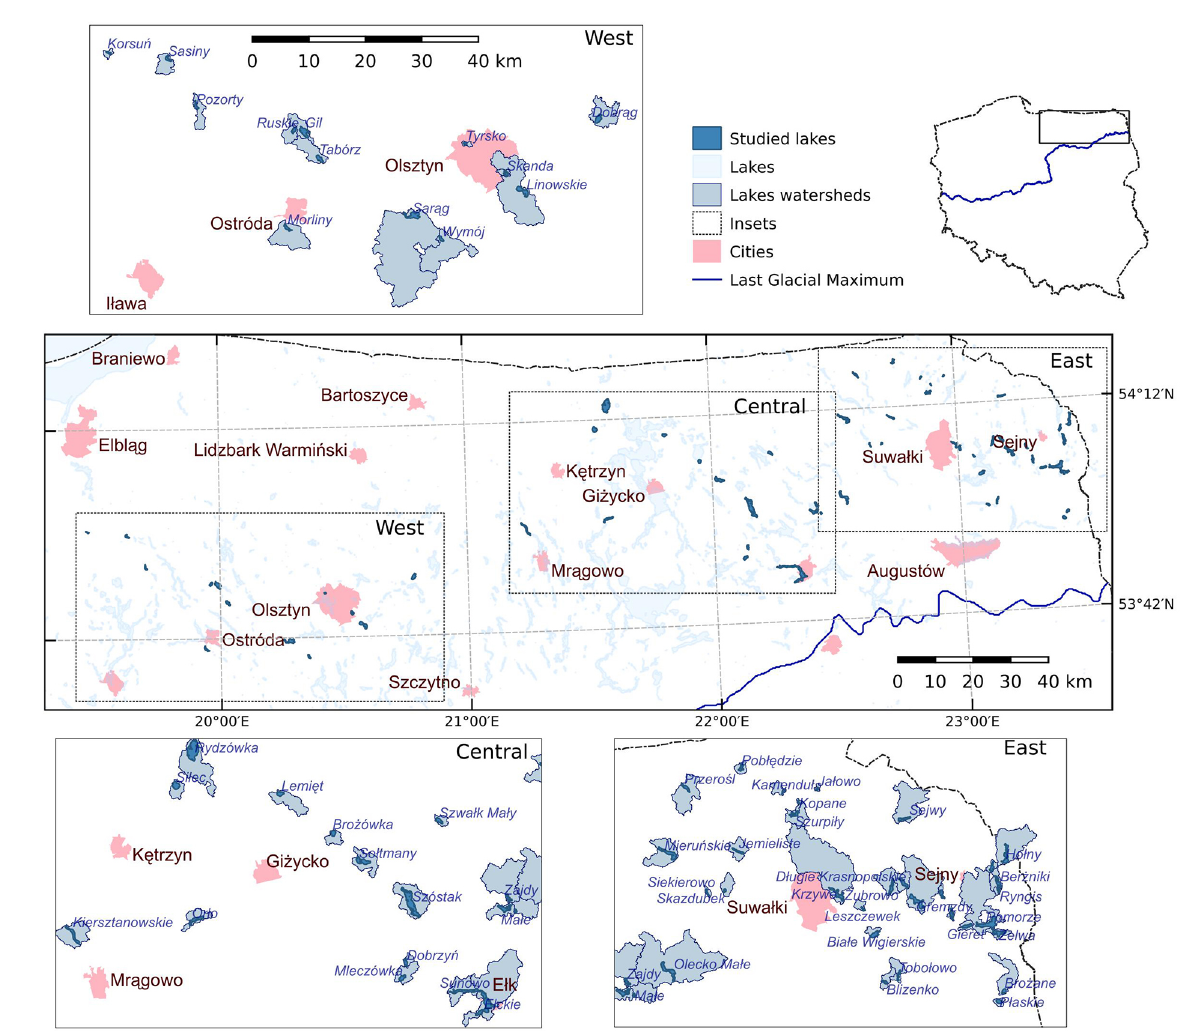
Fig. 1. Location of lakes and extent of the watershed on the study